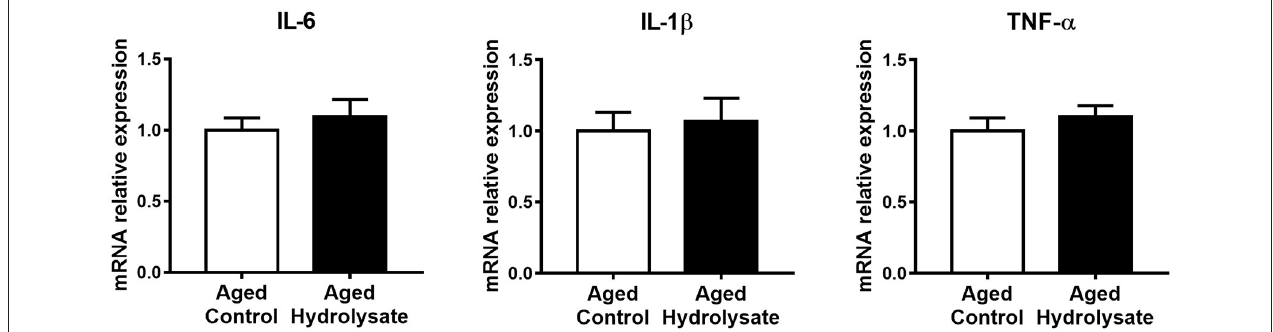
FIGURE 4 | Effects of the fish hydrolysate supplementation on pro-inflammatory cytokine expression in the hippocampus. Pro-inflammatory cytokines IL-6, IL-1 β , and TNF- α mRNA expression in the hippocampus of aged mice fed with the control diet or the hydrolysate-enriched diet for 10 weeks. n = 8 per group. Data are presented as mean ±